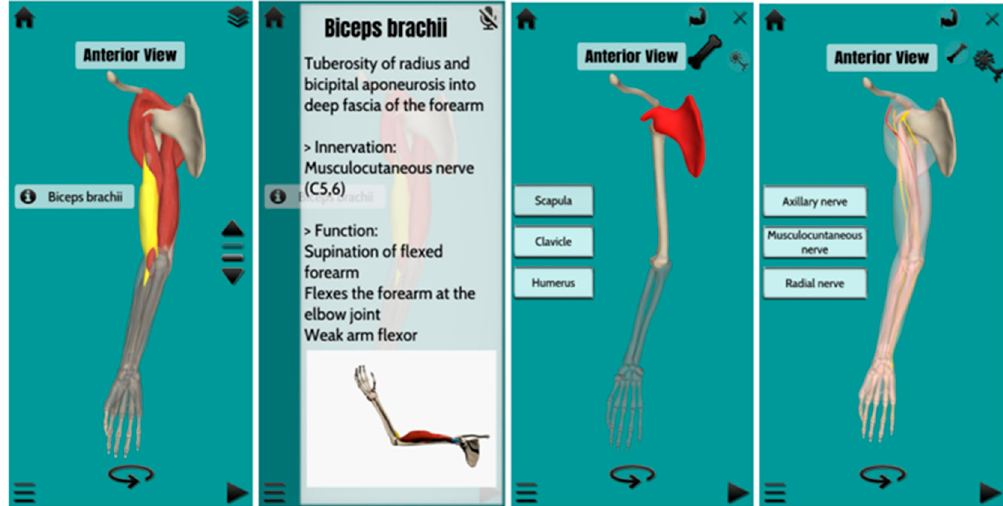
Figure 5. The changes made to the 3D mode, including final UI design and placement, during application development.